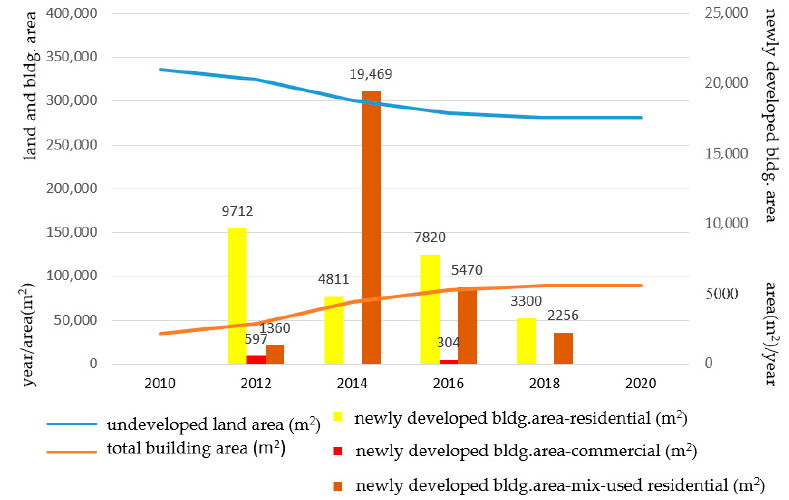
Figure 7. Changed area of lands and the newly added or developed area of buildings around Blue Pond Park.